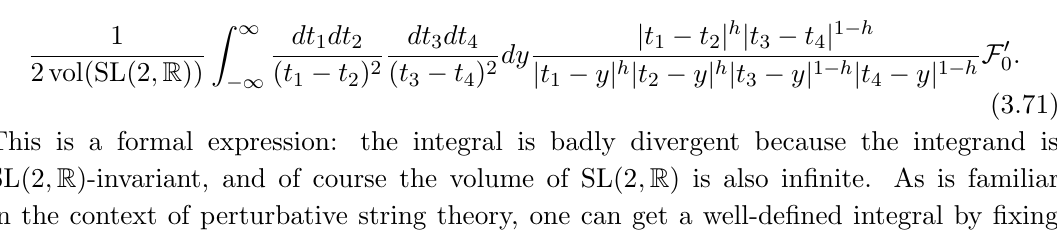
Figure 2 . The lowest order contribution to a four-point function rung" diagrams (a third diagram is missing because as usual we consider a four-point function with the disconnected contribution